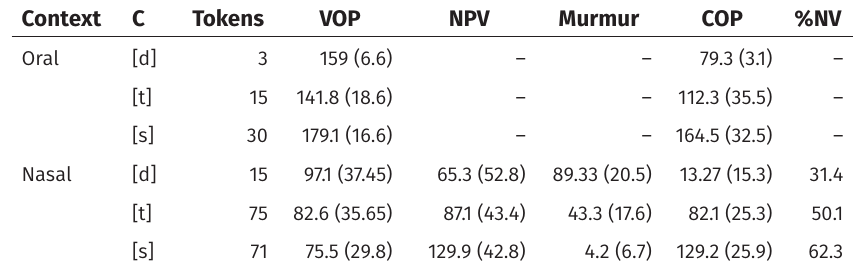
Table 3: Mean duration and standard deviation (in ms) of each portion by context and following